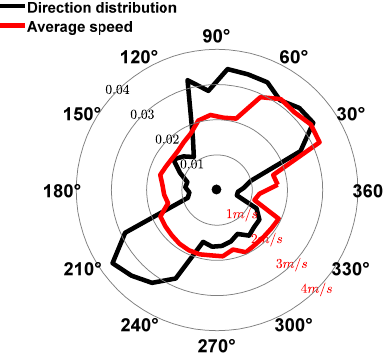
Figure 5. Wind distribution.